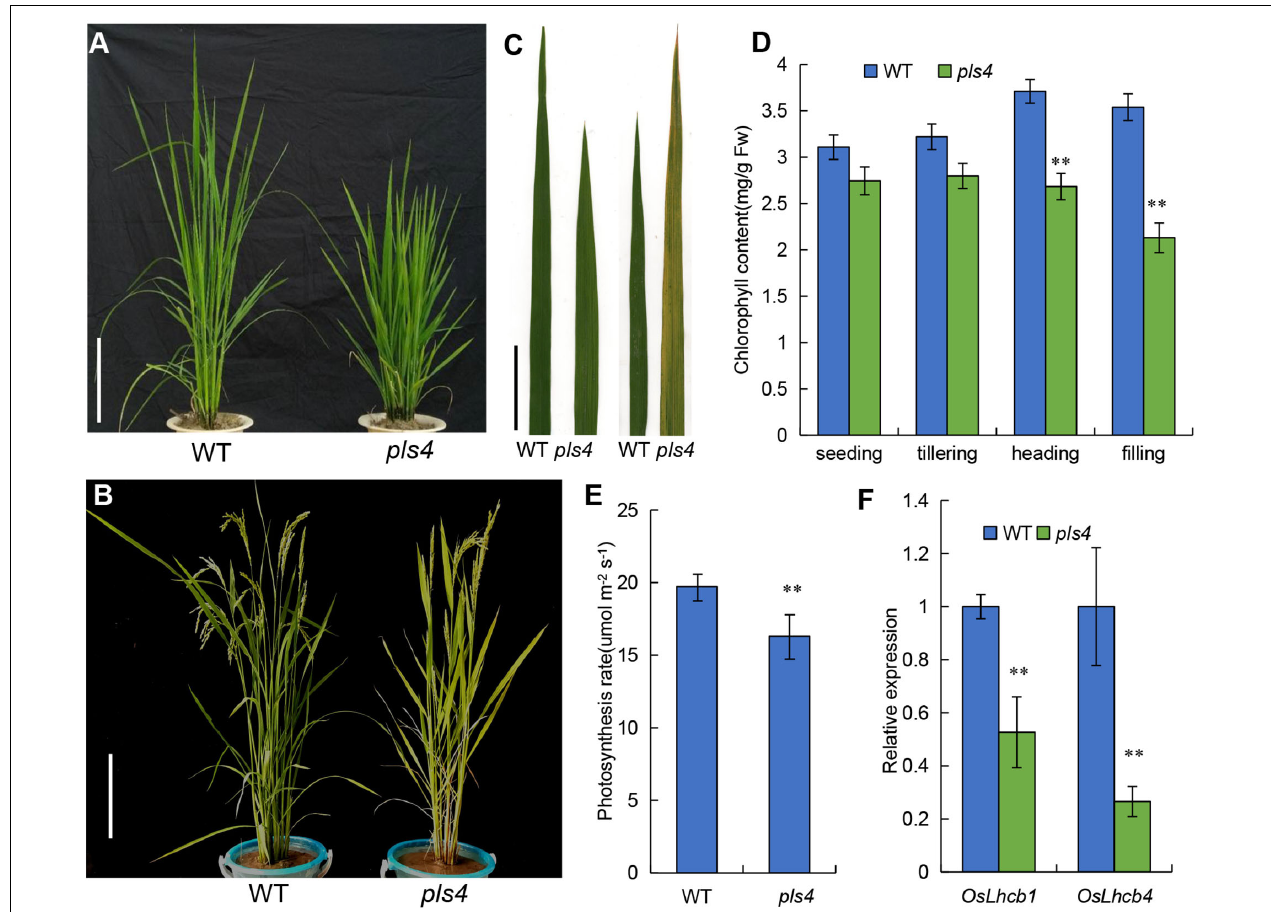
FIGURE 1 | Characteristics of the WT and pls4 mutant. (A,B) Phenotypes of the WT and pls4 mutant at the tillering and heading stages. Bars = 20 cm. (C) The leaves of the WT and pls4 mutant at the tillering and heading stages. Bars = 5 cm. (D) Chl content in the leaves of pls4 and the WT at four growth stages. Fw, fresh weight. (E) Determination of the photosynthesis rate of the WT and pls4 mutant at the heading stage. (F) Expression levels of OsLhcb1 and OsLhcb4 ; OsLhcb1 , light-harvesting Chl a/b-binding protein of photosystem II (PSII) ( LOC_Os10g41780 ); OsLhcb4 (LOC_Os07g37240). The data presented are the means ± SDs of three biological replicates. ** P < 0.01 (Student’s t